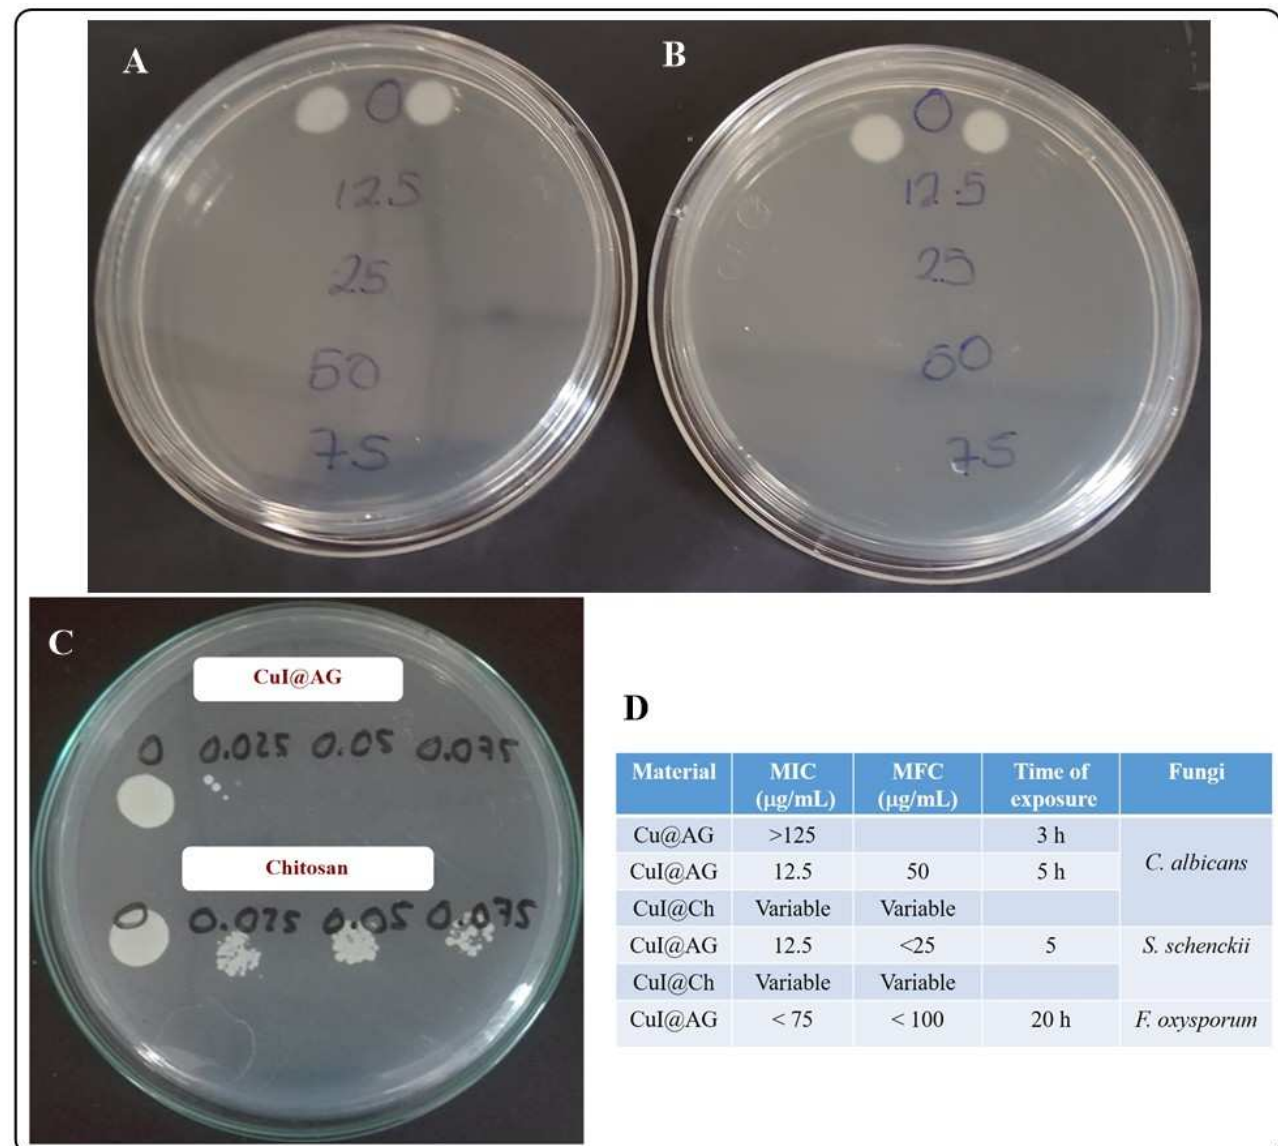
Figure 7. Summary of the antifungal activity of CuI NMs (5 h of exposure). ( A ) CuI@AG against S. schenckii . ( B ) CuI@Ch against S. schenckii . ( C ) CuI@AG and chitosan against C. albicans . ( D ) MIC and MFC